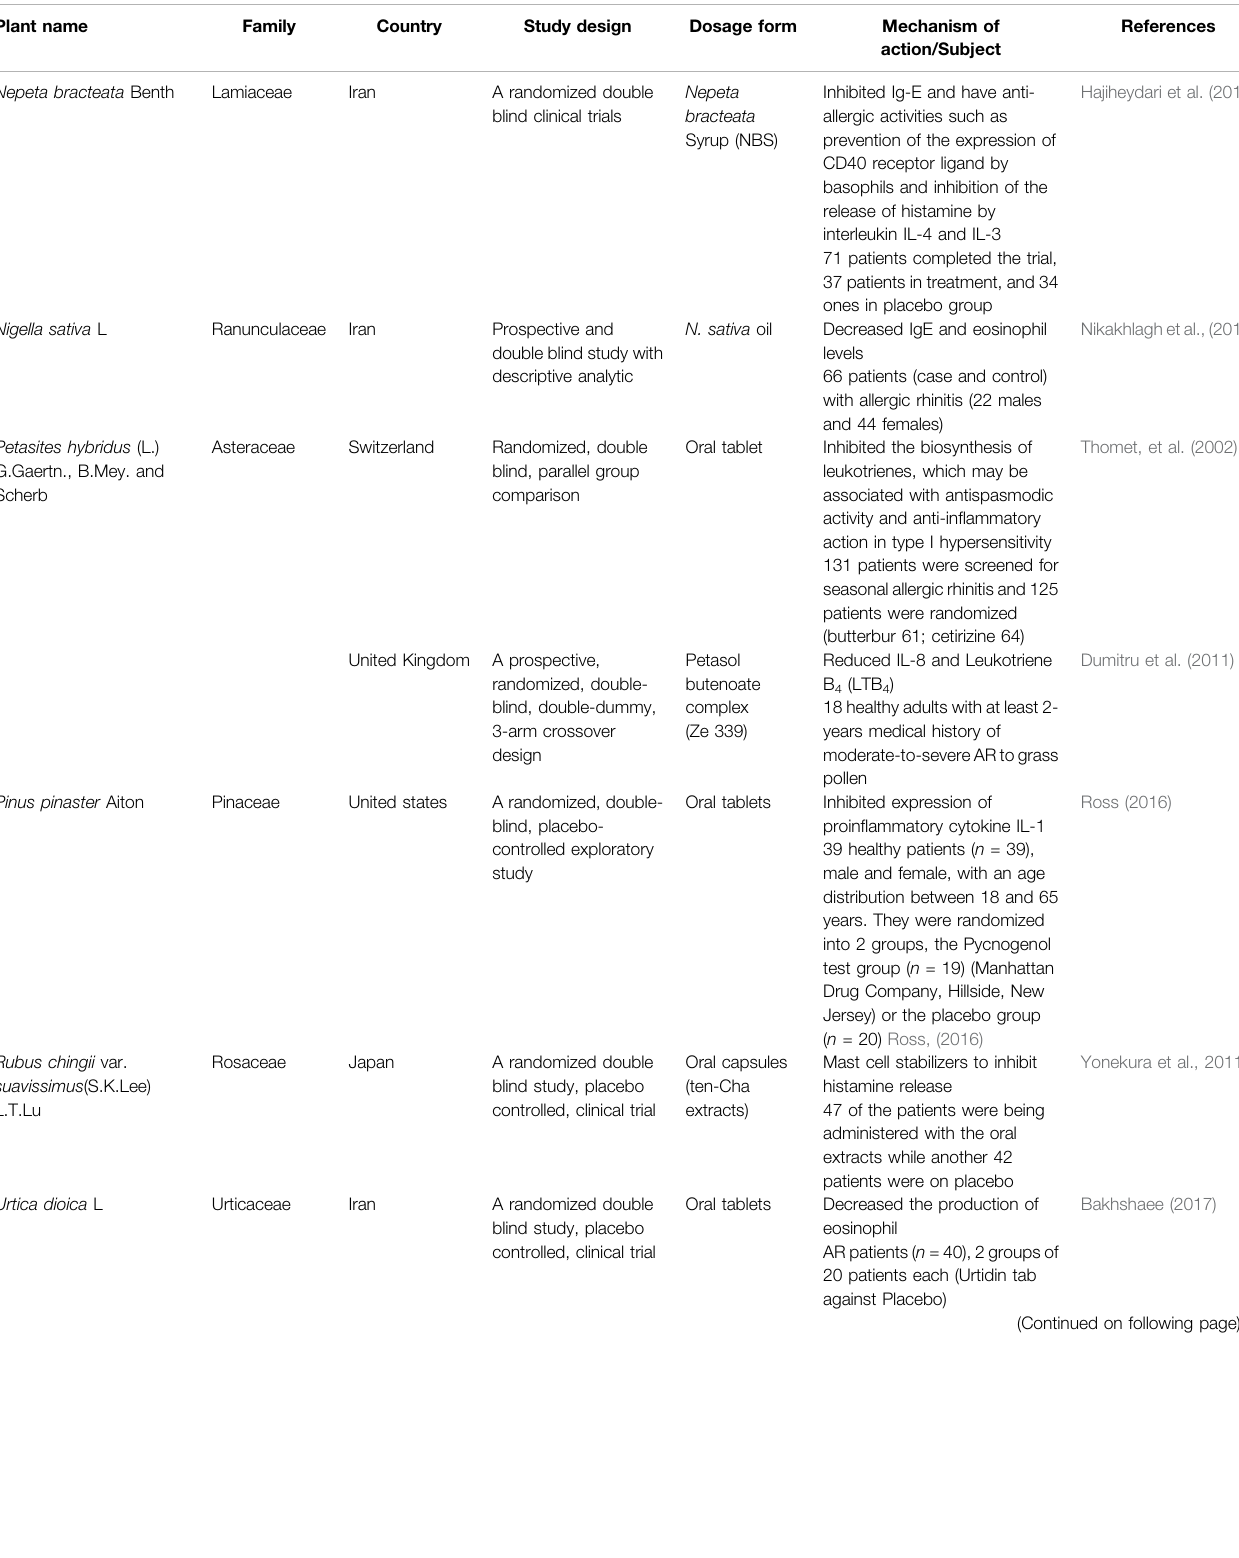
TABLE 2 | ( Continued ) Clinical trials studies of plants with anti-allergic